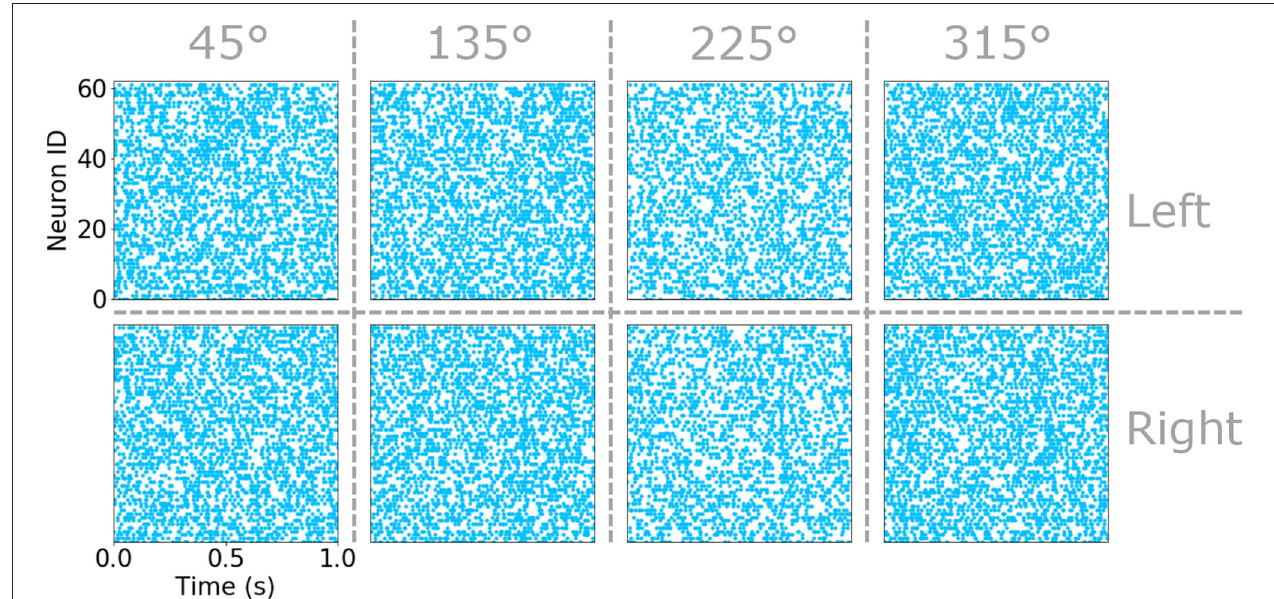
FIGURE 2 | Raster plots of the sensory hair spike time in the eight populations of sensitive to slow air currents. Sub-populations corresponding to the left an right cercus as well as the four preferred directions are indicated by vertical and horizontal dashed lines. Each raster plot marks the spike-time of each neuron in a sub-population (identified as a number between 0 and 59) with a blue point.